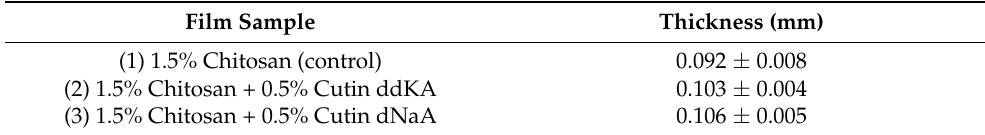
Table 9. Thickness (mm) of the selected film samples.